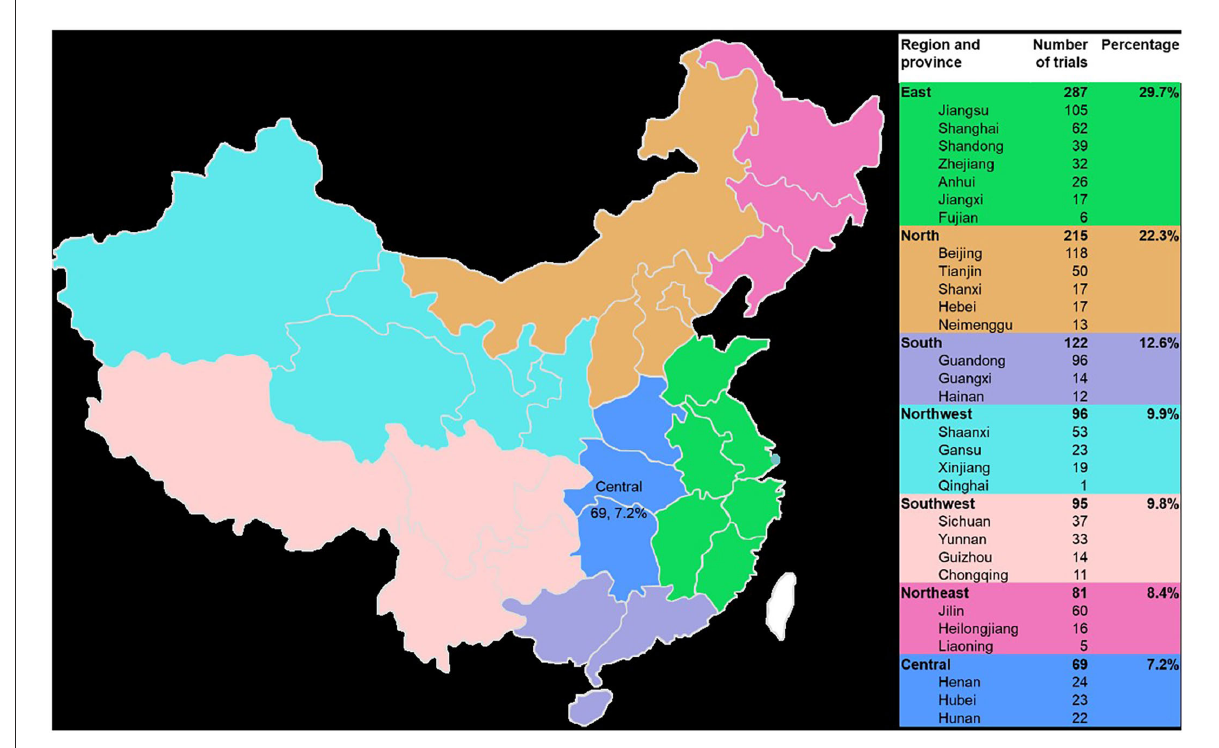
FIGURE6 Geographical distribution of the sponsors of the 965 included TCM clinical trials from 2013 to